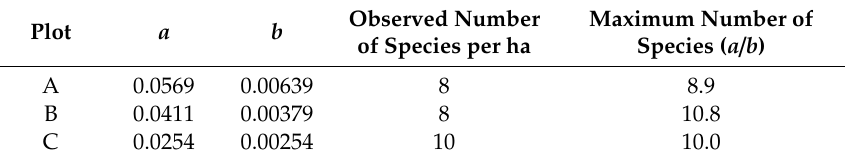
Table 2. Parameters of the Monod model for estimating the species–area relations. Plot a b